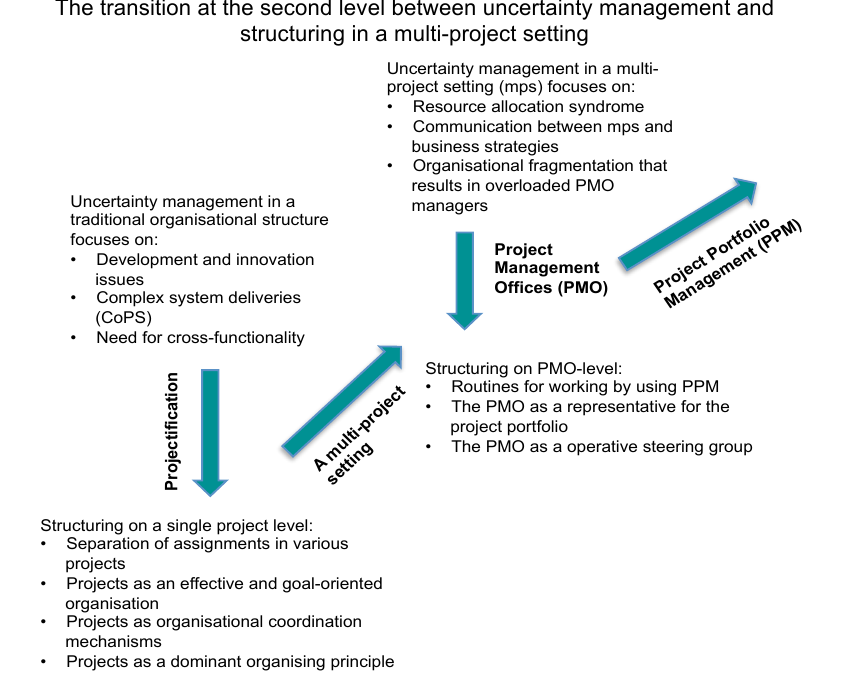
The transition at the second level between uncertainty management and structuring in a multi-project